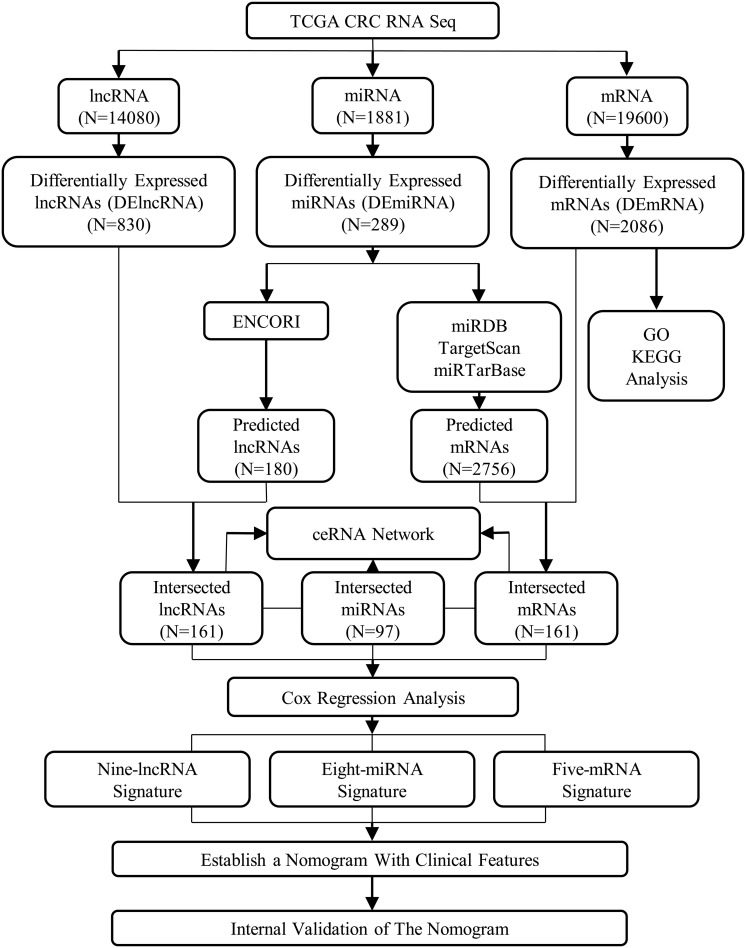
The flowchart of the designs and details of the lncRNA–miRNA–mRNA ceRNA network analysis.